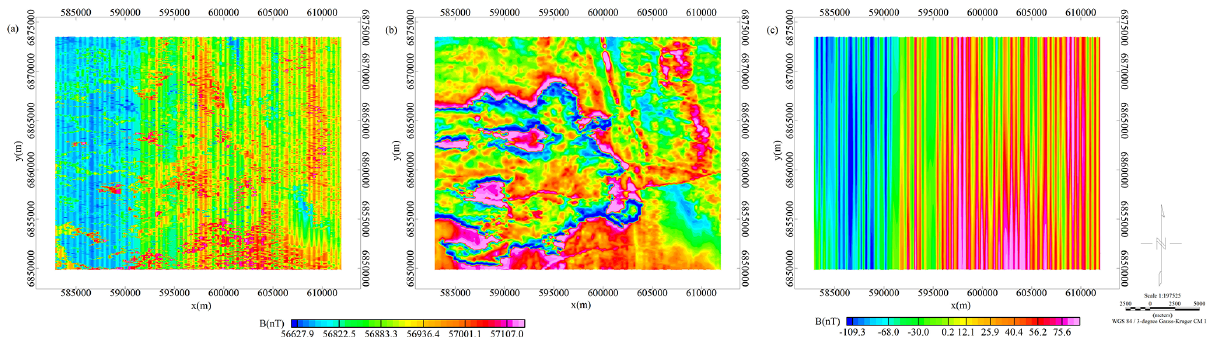
Figure 5. The leveling of the magnetic data. (a) The preprocessed smooth field. (b) Leveled data by the unidirectional variational model algorithm. The figure is shown with the same color bar as the leveling results in Fig. 1d. (c) Decomposed leveling errors.